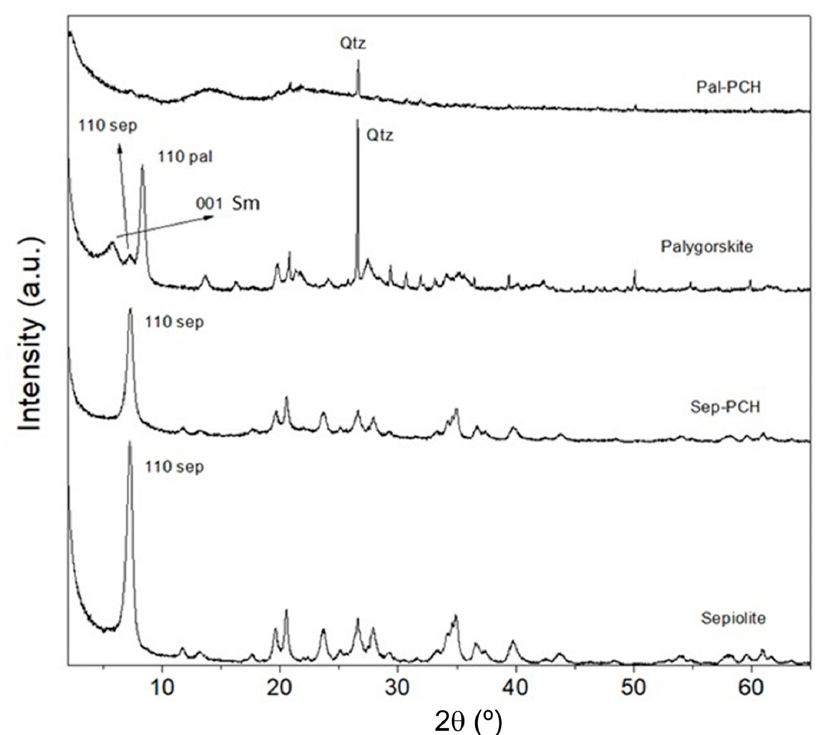
Figure 2. X-ray diffraction patterns of the raw sepiolite, sep-PCH, raw palygorskite and pal-PCH. Figure 2. X-ray di ff raction patterns of the raw sepiolite, sep-PCH, raw palygorskite and pal-PCH. Acronyms: (Qtz: quartz, Sm: smectite, Sep: sepiolite, Pal: palygorskite). Acronyms: (Qtz: quartz, Sm: smectite, Sep: sepiolite, Pal: